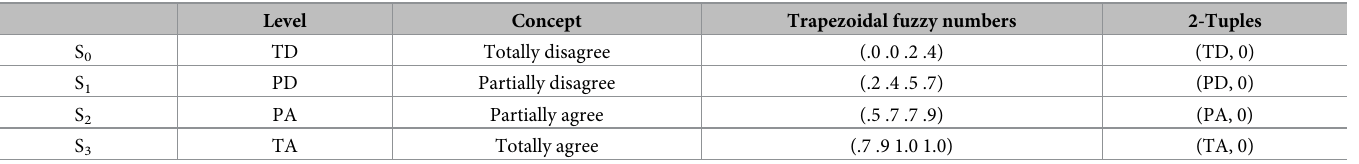
Table 3. Scale of linguistic preferences comparable to each alternative structure.